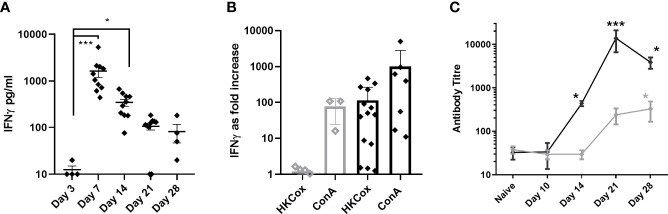
Immune response in marmosets following an inhalational challenge with (C) burnetii.
(A) Circulating levels of IFNγ. Significance by ANOVA indicated by asterisks ***p<0.001 and *p<0.05 (B) fold increase in IFNγ production (above baseline) following stimulation of Day 21 or 28 (black diamond) or Day 3 (gray diamond) viable spleen cells to heat-killed (HK) Coxiella burnetii or ConA (control), (C) antibody response to Phase I (gray diamond) and Phase II (black diamond) antigens. Data is presented as the mean and standard error.